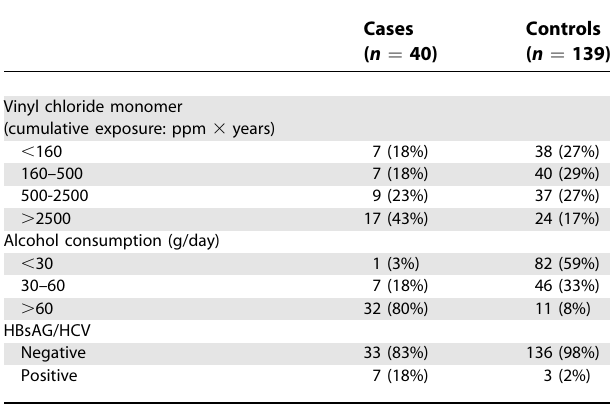
Table. Exposure among Liver Cirrhosis Cases and Controls